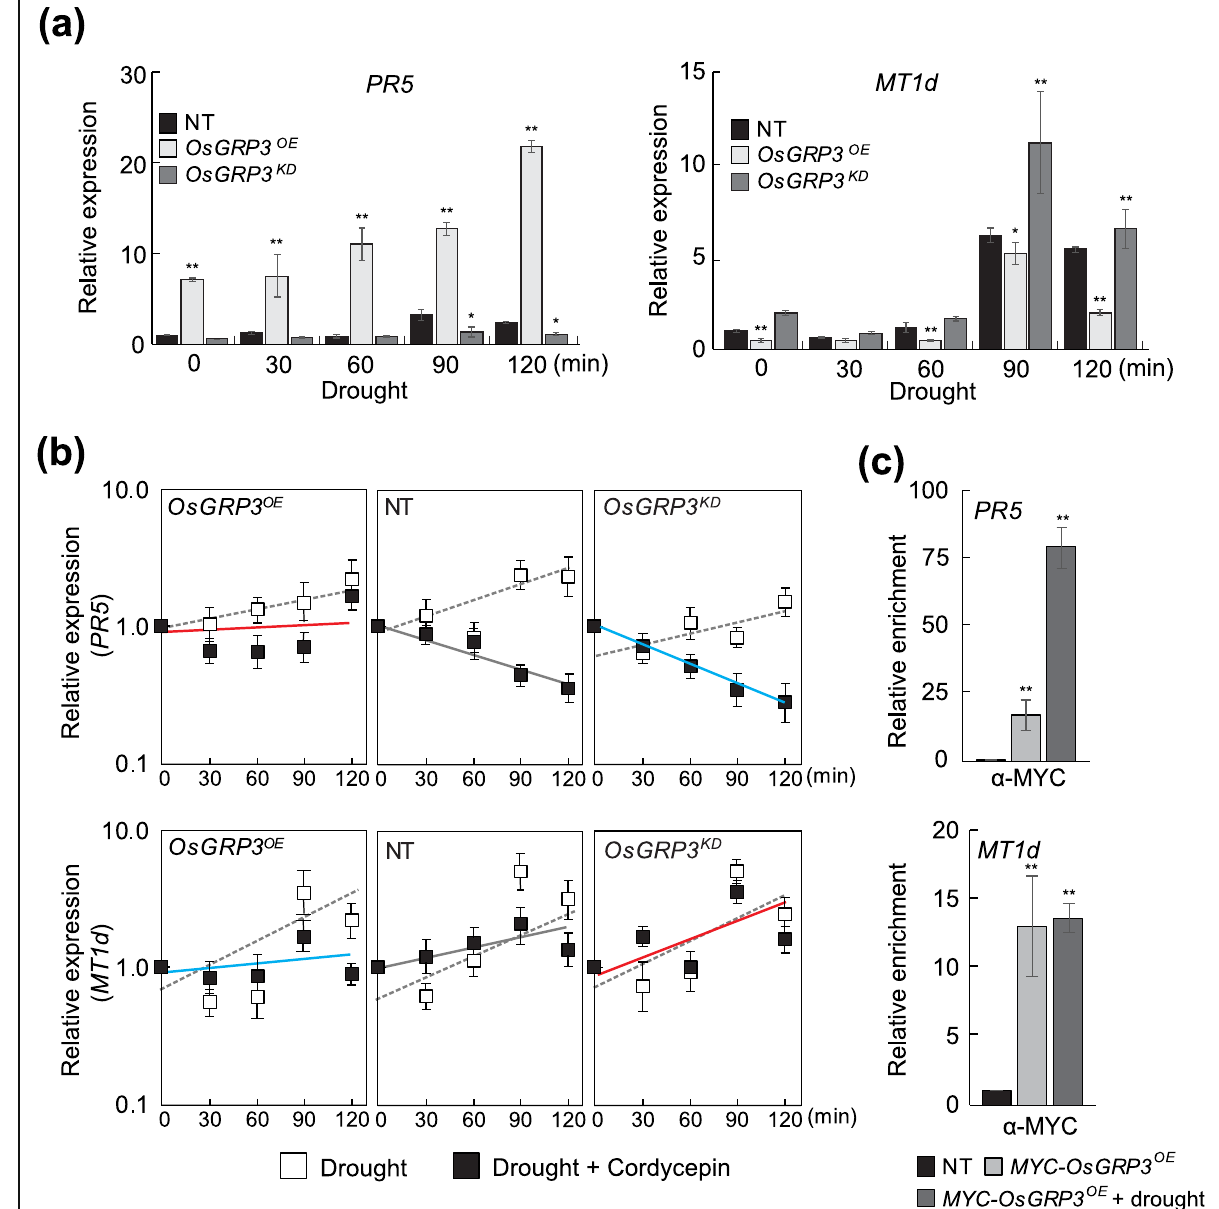
Fig. 6 Effects of drought on the function of OsGRP3. a Expression patterns of PR5 and MT1d were analyzed under drought conditions. Two-week- old non-transgenic plants (NT), OsGRP3 overexpressing ( OsGRP3 OE ) and RNAi-mediated OsGRP3 suppressing ( OsGRP3 KD ) transgenic plants were air- dried and harvested at indicated time points. Total RNAs isolated from harvested leaves were analyzed by qRT-PCR. Rice UBIQUITIN ( OsUBI ) was used as the internal control for normalization. b The stability of PR5 and Mt1d transcripts was analyzed under drought conditions. Two-week-old NT, OsGRP3 OE and OsGRP3 KD transgenic plants were pre-treated with distilled water or 1 mM cordycepin for 30 min. Plants were then treated with drought stress and harvested every 30 min after the treatments. Total RNAs extracted from the harvested samples were applied for qRT-PCR analysis. c Analysis of OsGRP3 interaction with PR5 and MT1d transcripts under drought conditions. For analyzing the interaction of OsGRP3 with PR5 and Mt1d transcripts, two-week-old MYC-OsGRP3 OE plants were harvested 2 h after drought treatments and applied for RNA-IP experiments. NT plants were used as a negative control. Fold enrichment was normalized to the value of NT plants. a - c Data represent the mean value ± standard deviation (SD) ( n = 3, biological replicates). a and c Asterisks indicate a statistically significant difference compared with NT. * P < 0.05, ** P < 0.01; One-way